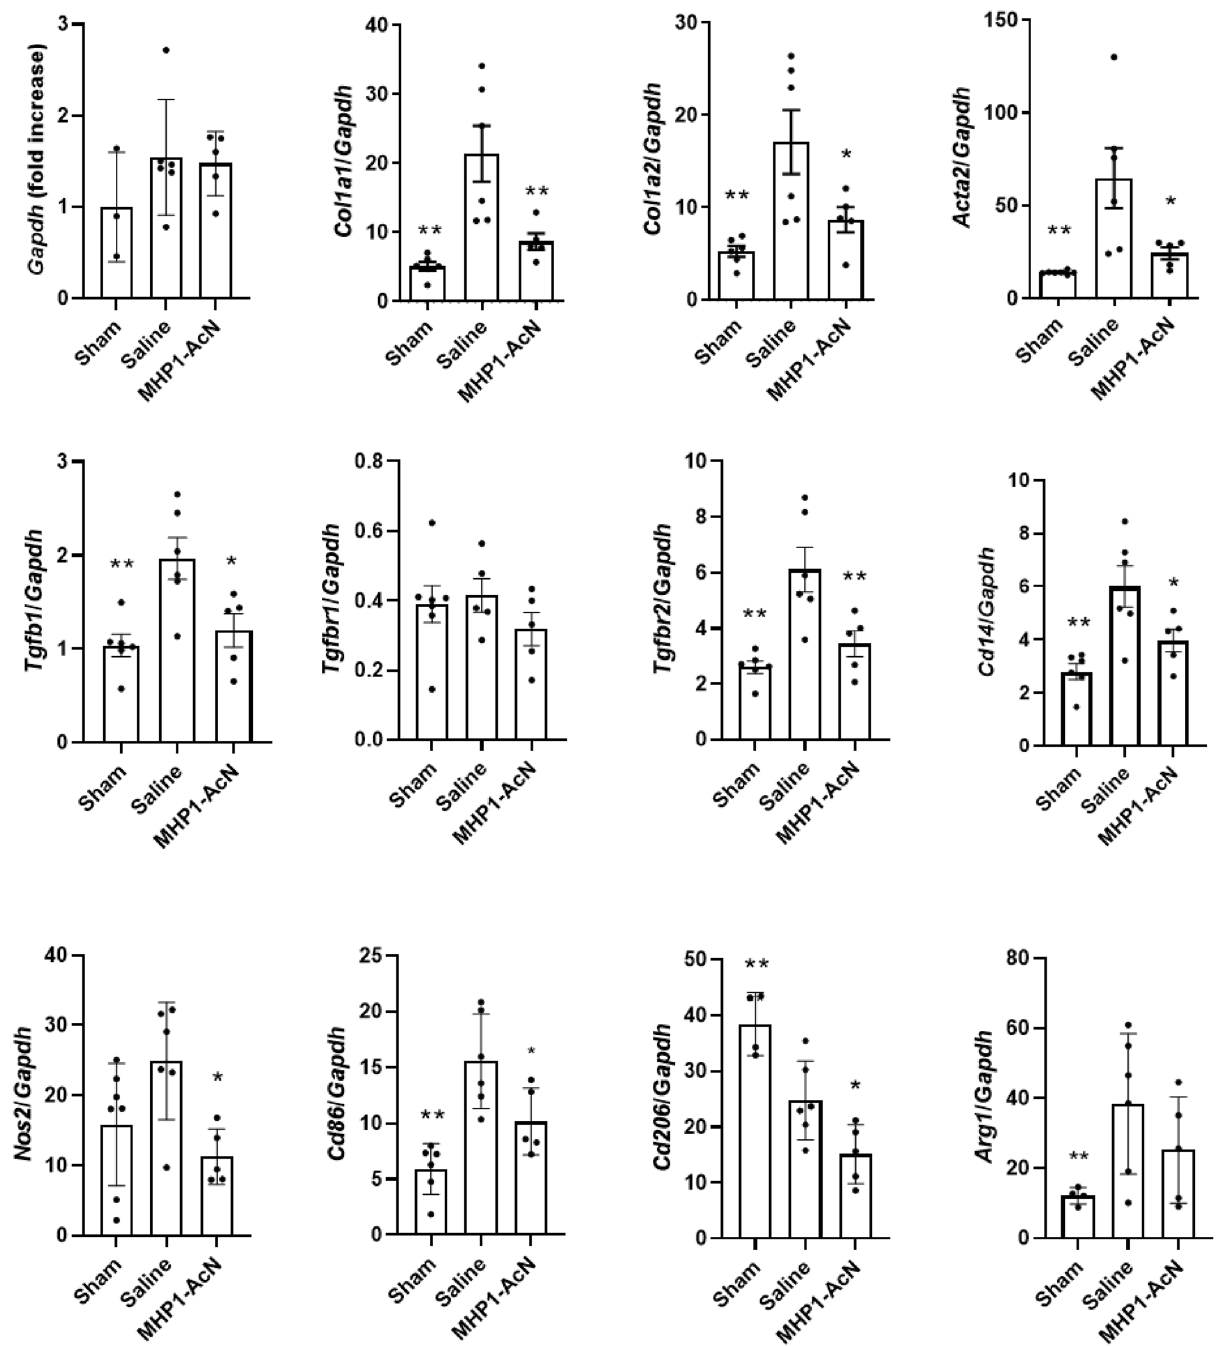
Figure 2. MHP1-AcN prevented the progression of bleomycin-induced lung fibrosis. Expression of fibrosis ( Col1a1 and Col1a2 ), myofibroblast ( Acta2 (αSMA)), TGF-β signaling ( Tgfb1 , Tgfbr1 , Tgfbr2 ), M1 marker ( Nos2 (iNOS), Cd86 ), M2 marker ( Cd206 , Arg1 )-related genes, and Cd14 on day 14. There were no differences in Gapdh . * p < 0.05, ** p < 0.01 vs saline-treated mice. n = 3–6 in sham-operated group, n = 6 in saline-treated group, n = 5 in MHP1-AcN-treated